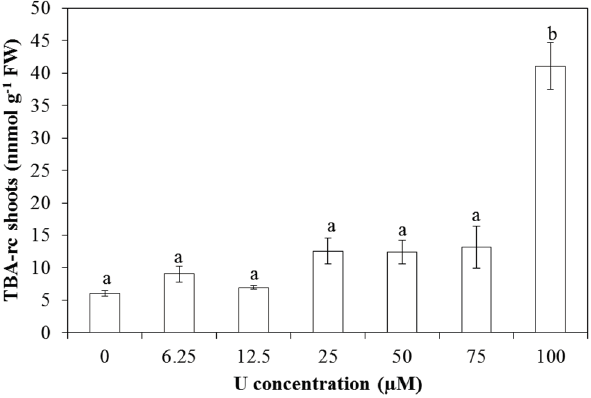
Figure 3. Level of lipid peroxidation, based on the amount of thiobarbituric acid reactive compounds (TBA-rc) in Arabidopsis thaliana leaves exposed to different U concentrations for three days at pH 7.5. Values represent the mean ± S.E. of at least four biological replicates. Data points with different letters are significantly different ( p <